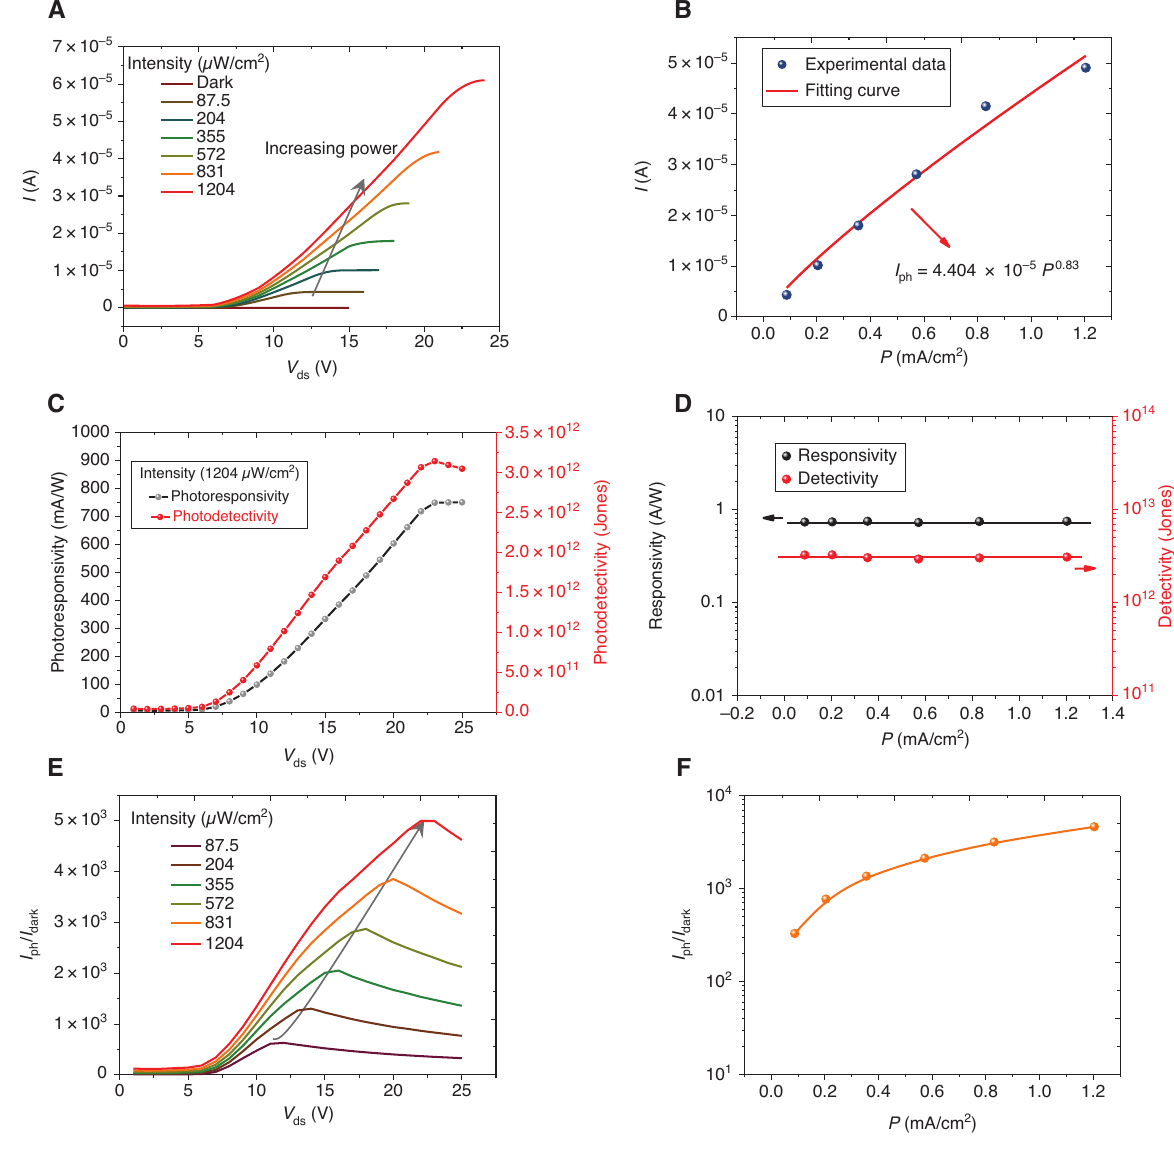
O /Si heterojunction photodetector. 2 3 O layer is 13.36 nm. (B) 2 3 and ds / I ratio as a function of V and illumination power intensities, ph dark ds